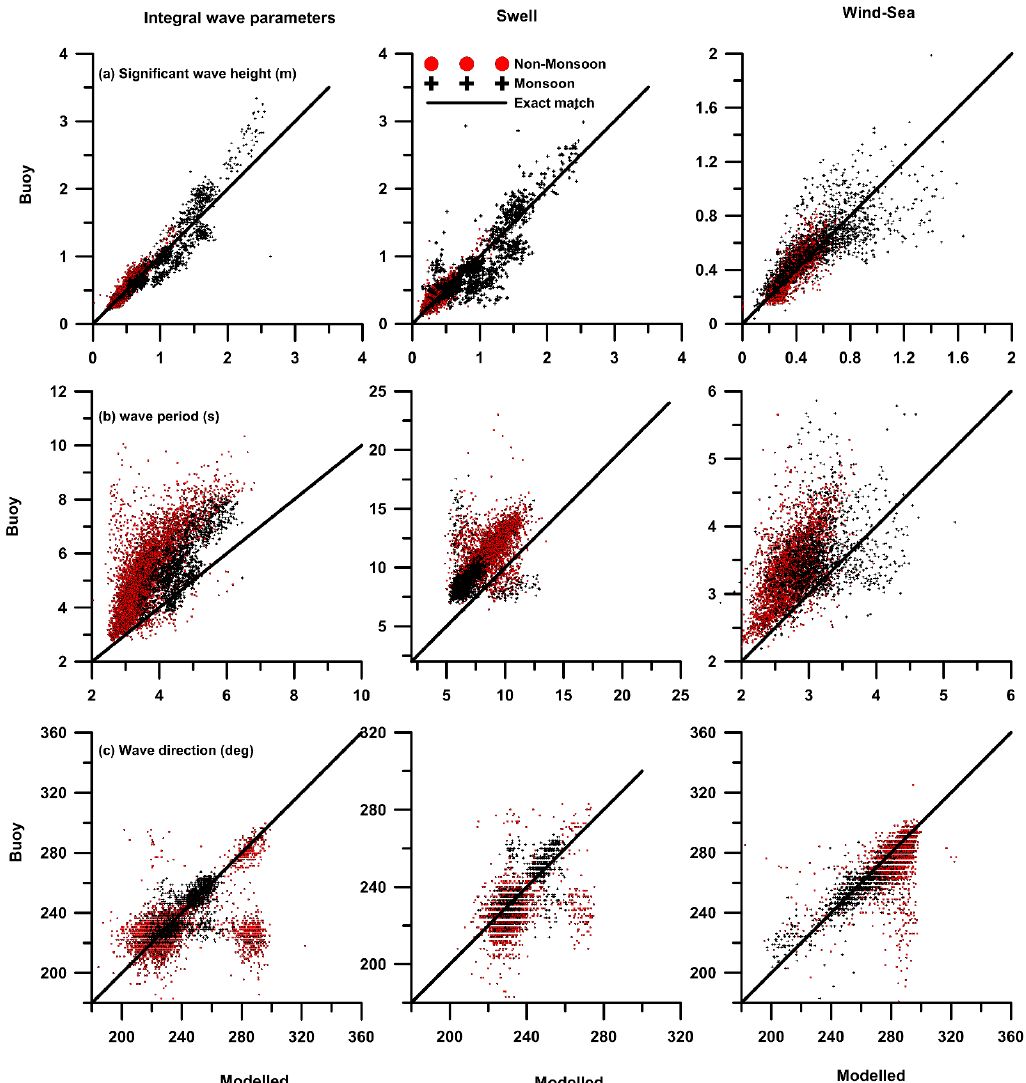
Figure 6. Scatter plot of ( a ) significant wave height, ( b ) mean wave period and ( c ) mean wave direction for integral wave parameters, swell and wind ‐ sea between measured buoy data at 5 m water depth and that based on wave model.